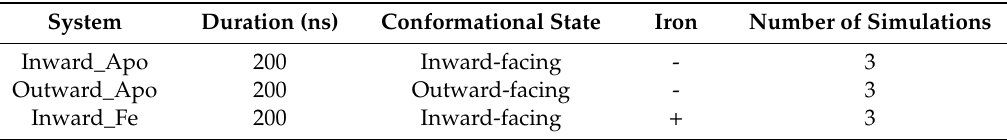
Table 1. Systems subjected to MD